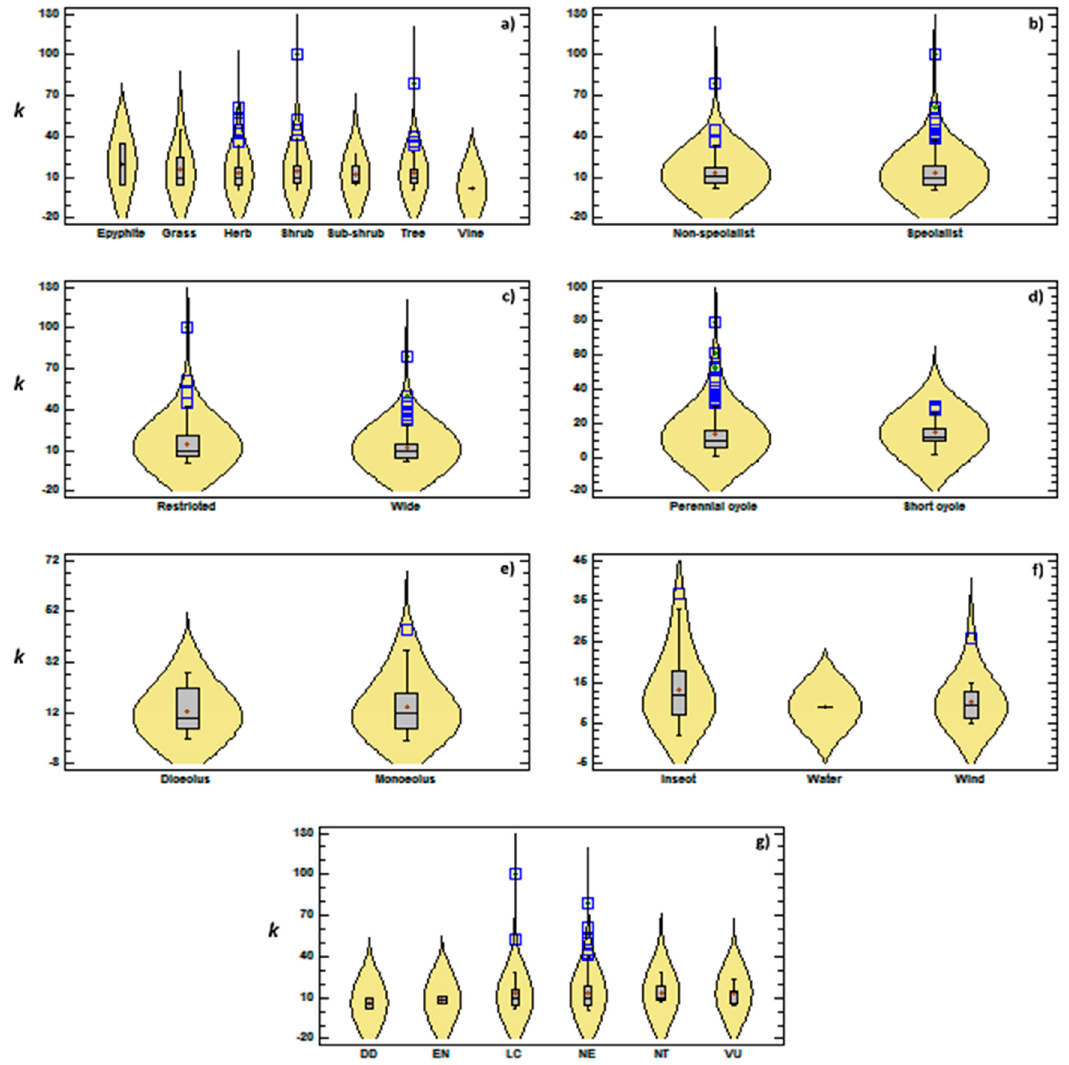
Figure 6. Mean number of haplotypes ( k ) observed in the different angiosperm groups targeted in studies that used chloroplast markers: ( a ) life mode; ( b ) habitat specialist/non-specialist; ( c ) geographic distribution; ( d ) reproductive cycle; ( e ) type of flower; ( f ) type of pollinator, and ( g ) IUCN category. + = average; □ = outliers.